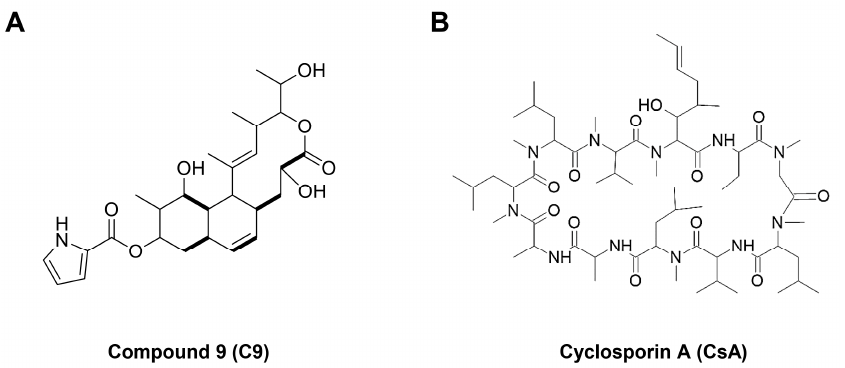
Figure 1. The chemical structures of ( A ) C9 and ( B ) CsA.